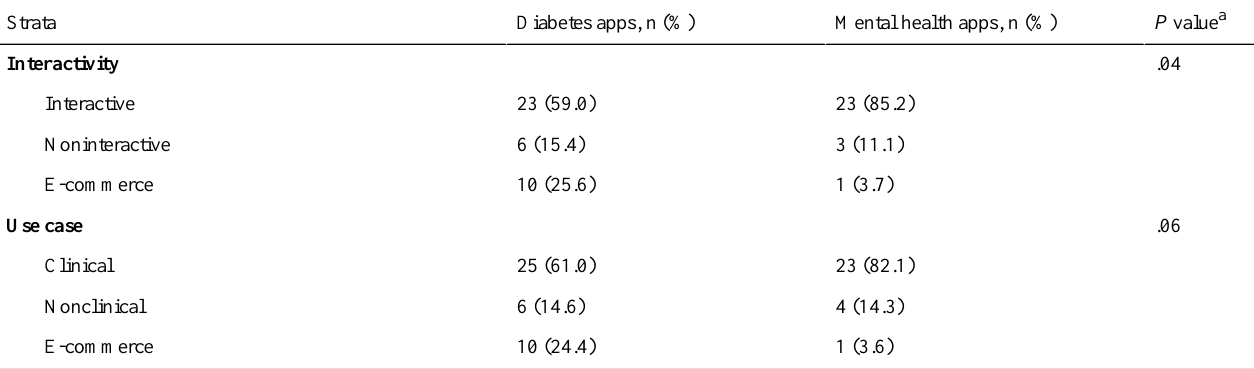
Table 2. Characteristics of diabetes and mental health mobile apps by Indian